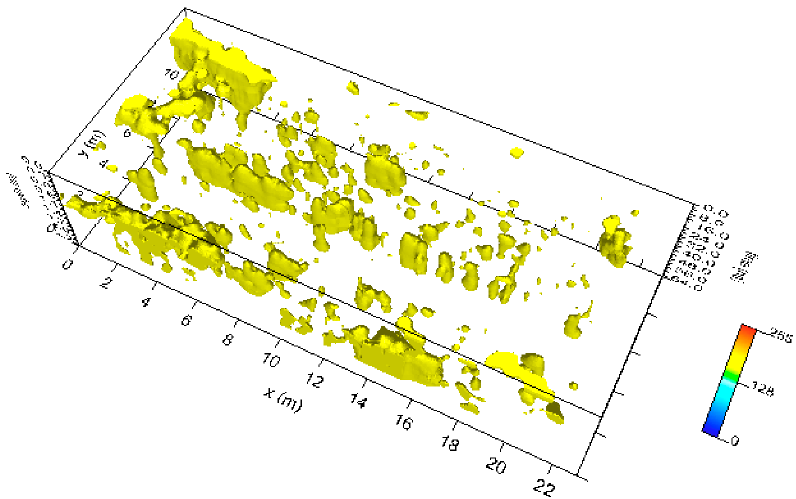
Figure 9. Plaza de Armas: sector 1: three-dimensional amplitude.